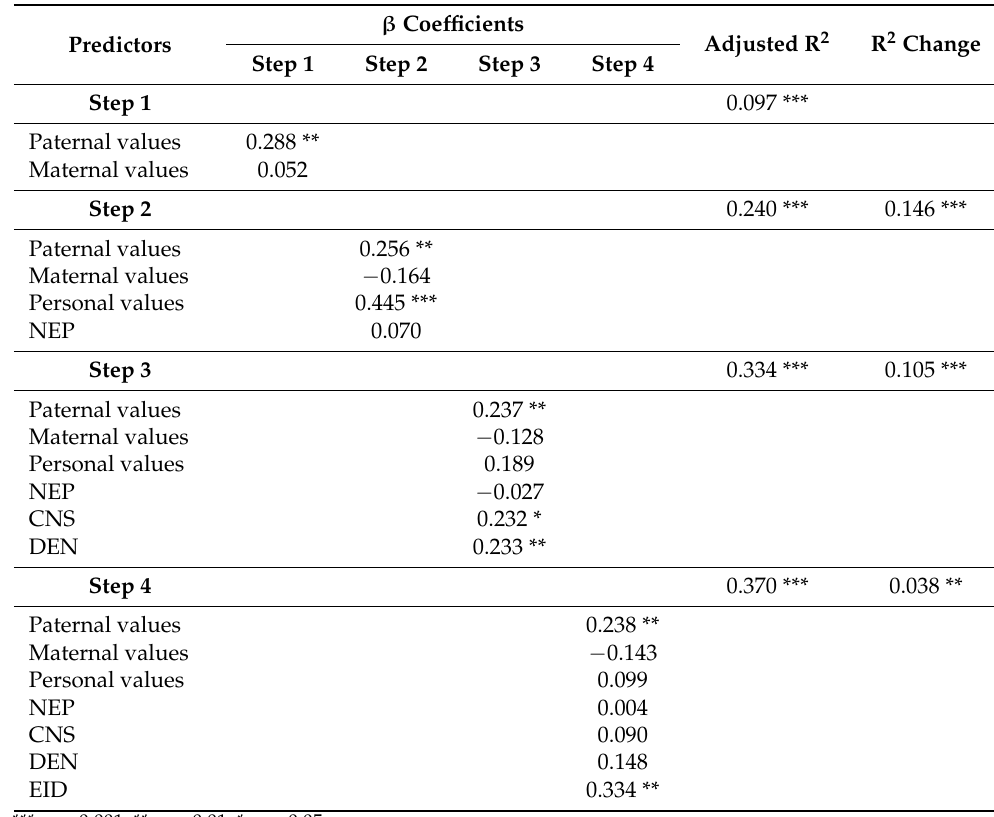
Table 4. HMRA: predictors of strong ecological